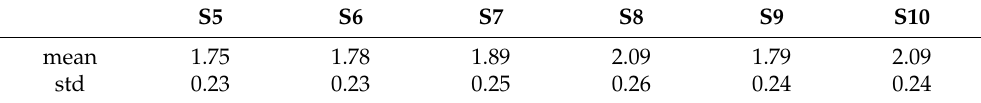
Table 3. Comparison of estimation accuracy in the next six examined scenarios in Section